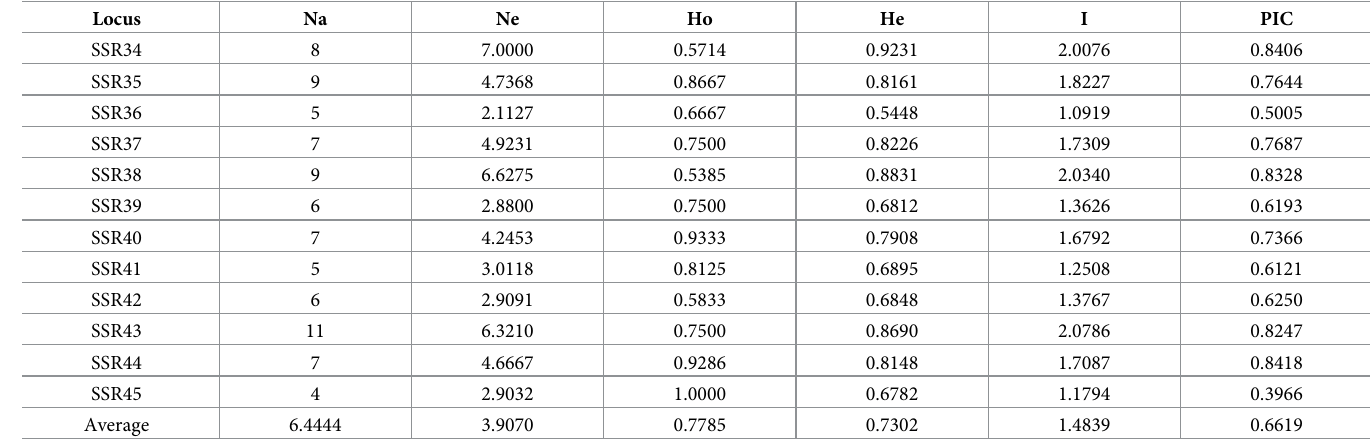
PLOS ONE | https://doi.org/10.1371/journal.pone.0227794 January 30,